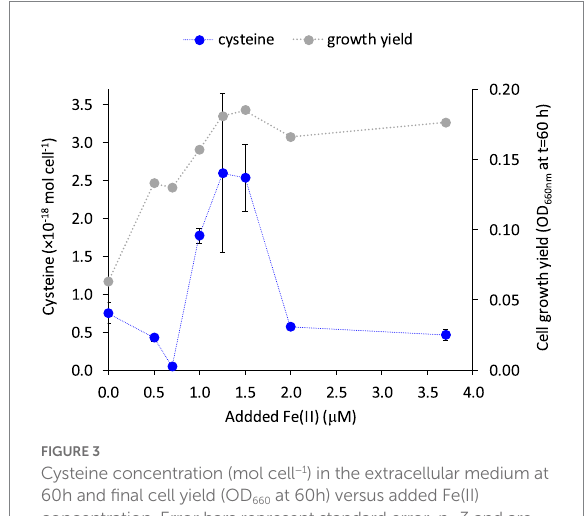
FIGURE 3 Cysteine concentration (mol cell − 1 ) in the extracellular medium at 60 h and final cell yield (OD 660 at 60 h) versus added Fe(II) concentration. Error bars represent standard error, n = 3 and are smaller than visible in several cases.